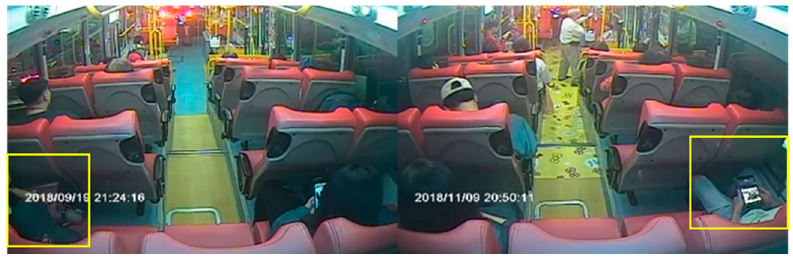
Figure 9. Occlusion range of the rear camera.